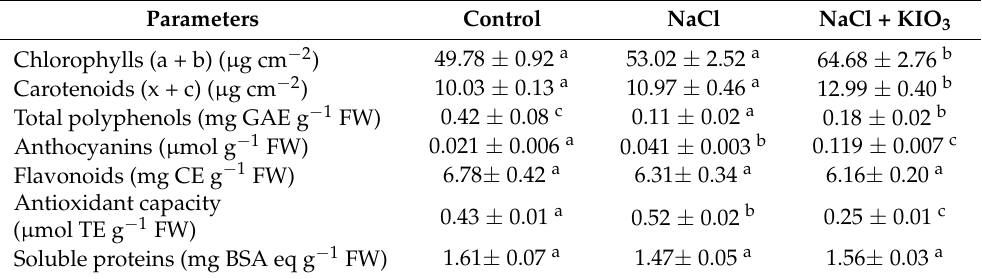
Table 3. Chemical composition of control plants and plants fertilized with nutrient solution with salt (NaCl) added or with salt plus iodine (NaCl + KIO 3 ). Data are means ± SE. Parameters Control NaCl Chlorophylls (a + b) ( µ g cm − 2 )